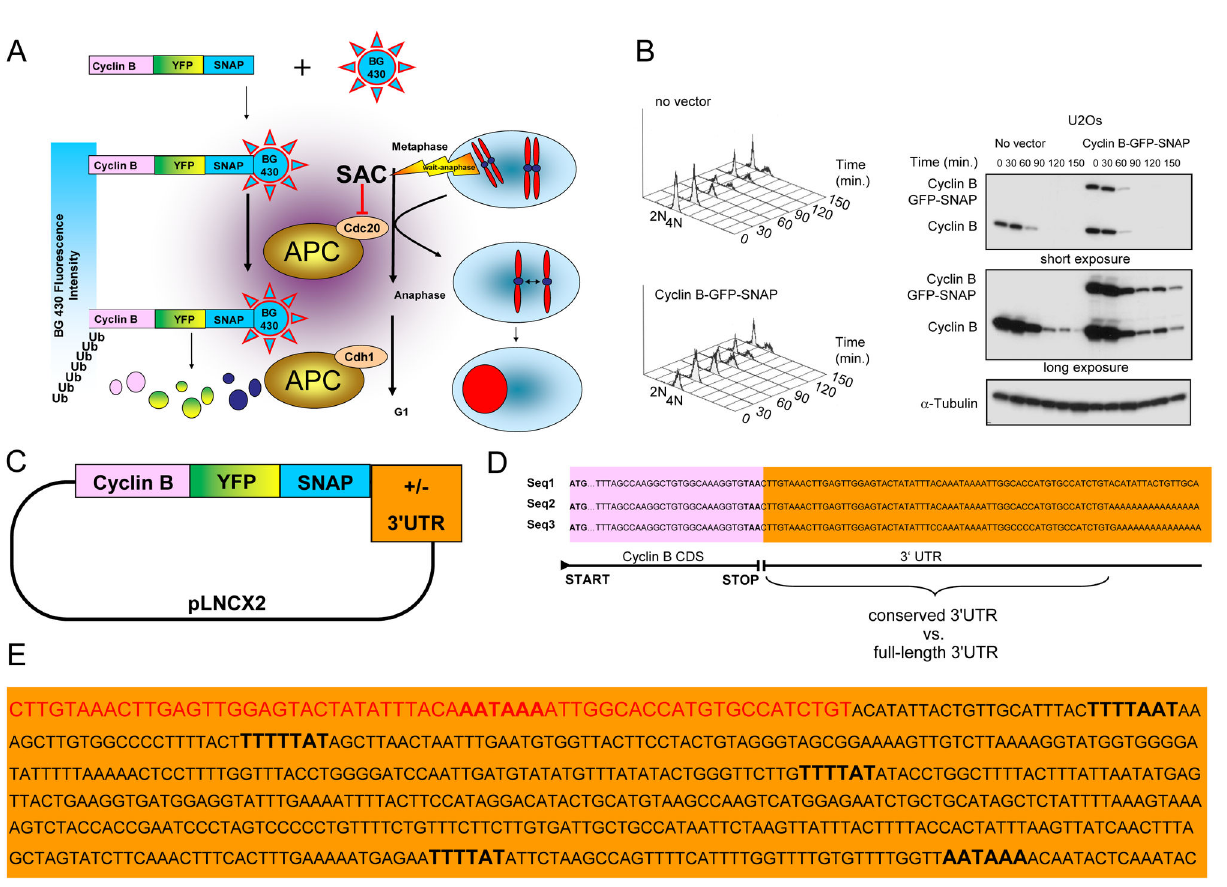
Figure 1. A double-chimeric system allowing the study of cyclin B kinetics at the single cell level in the presence and absence of the cyclin B 3'UTR. (A) A double-chimeric cyclin B reporter protein allowed the monitoring of whole protein expression by YFP fluorescence and degradation by pulse-chase labeling with the membrane-permeable SNAP substrate BG430. (B) Exemplary protein kinetics of the double-chimeric cyclin B reporter with GFP-SNAP were assessed by Western Blotting. Expression of the reporter protein and endogenous cyclin B following a nocodazole release are shown. (C) Plasmid map of the retroviral pLNCX2 vector indicating the sequence encoding the double-chimeric reporter and the 3' untranslated region (UTR). (D) Listing of different 3'UTRs found in available cyclin B full-length clones. (E) Sequence of the full-length 3'UTR indicating the sequence of the short 3'UTR variant in red and the hexanucleotide sequences (AATAAA) and the CPEs (T